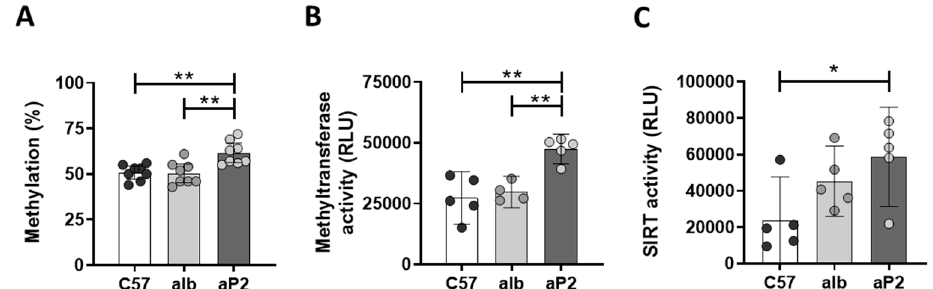
Figure 4. DNA methylation in isolated hepatocytes. ( A ) Methylation state of the mouse Igfbp2 promoter (position 2912, sequence ID: AC121498.12), ( B ) activity of methyltransferases, and ( C ) sirtuins (SIRT) in hepatocyte whole-cell lysates from C57Bl6 (C57), alb-SREBP-1c (alb), and aP2-SREBP-1c (aP2) mice. Data are expressed as mean ( ± 95% CI; n = 4–8). Statistics: ANOVA with Sidak correction: ** p < 0.01 and * p < 0.05. RLU: relative luminescence units.